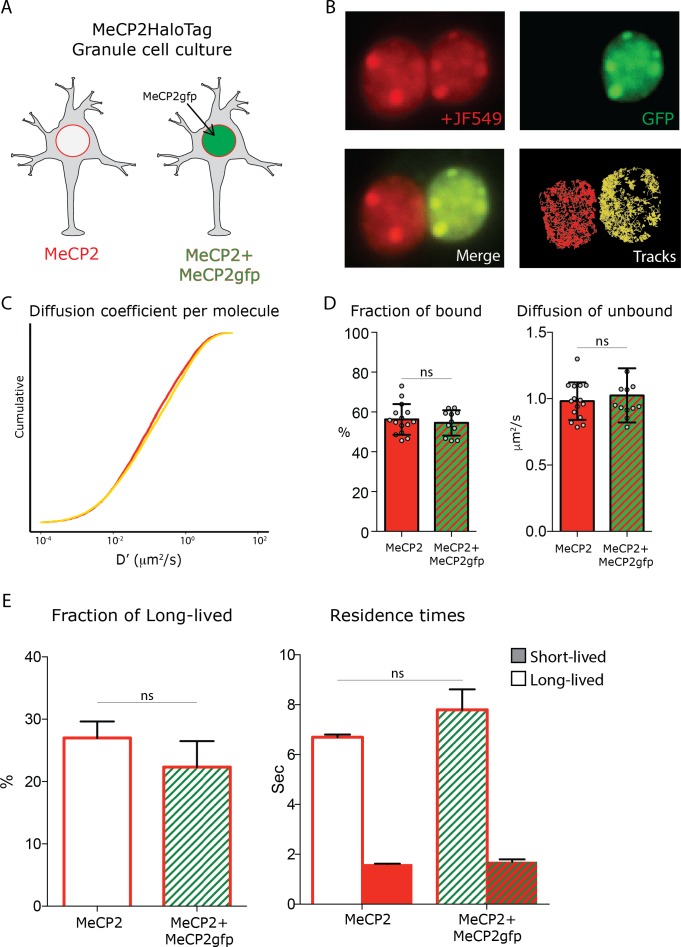
MeCP2 overexpression does not affect its nuclear kinetics.A schematic representation of the experimental design. Granule cells from MeCP2-HaloTag animals transfected with a construct expressing MeCP2-GFP fusion protein were co-cultured with untransfected MeCP2-HaloTag Granule cells. (B) Representative images of cultured MeCP2-HaloTag Granule cell nuclei labeled with the Halo-ligand JF549 (red), where a fraction of the cells also express an exogenous MeCP2-GFP protein (green). Live single molecule tracks were recorded from the two co-cultured conditions in parallel. (C) Cumulative distribution of diffusion coefficient (D’, μm2/s) calculated for individual molecules of MeCP2-HaloTag in wild type Granule cells (~15,000 molecules, red) or co-cultured cells overexpressing MeCP2 (MeCP2+MeCP2gfp,~10,000 molecules, yellow). (D) Fraction of bound molecules and average diffusion coefficient of the unbound molecules calculated in each cell by SpotOn for endogenous MeCP2 in wild type cells (15 cells) and in co-cultured granule cells overexpressing MeCP2 (12 cells). Graphs show mean and standard deviation of single cell values (gray dots) and compare the two conditions by two-tailed unpaired t-test: ns (p>0.05) (E) Dwell time analysis was performed on the two conditions similarly to what is shown in Figure 1—figure supplement 2. The fraction of the molecules that display long-lived dwell time and the Resident Time (RT) of short and long-lived molecules were calculated for individual experiments and plotted as histograms displaying mean and standard deviation. Two-tailed unpaired t-test shows no significant changes between the two MeCP2 expression levels (ns, p>0.05).